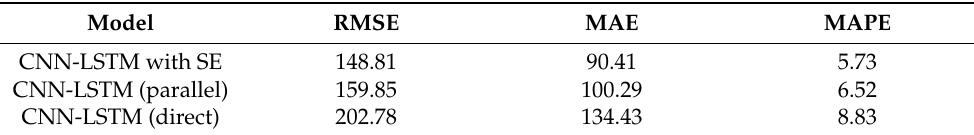
Table 5. Performances of the proposed CNN-LSTM with SE, CNN-LSTM (parallel), and CNN-LSTM (direct)